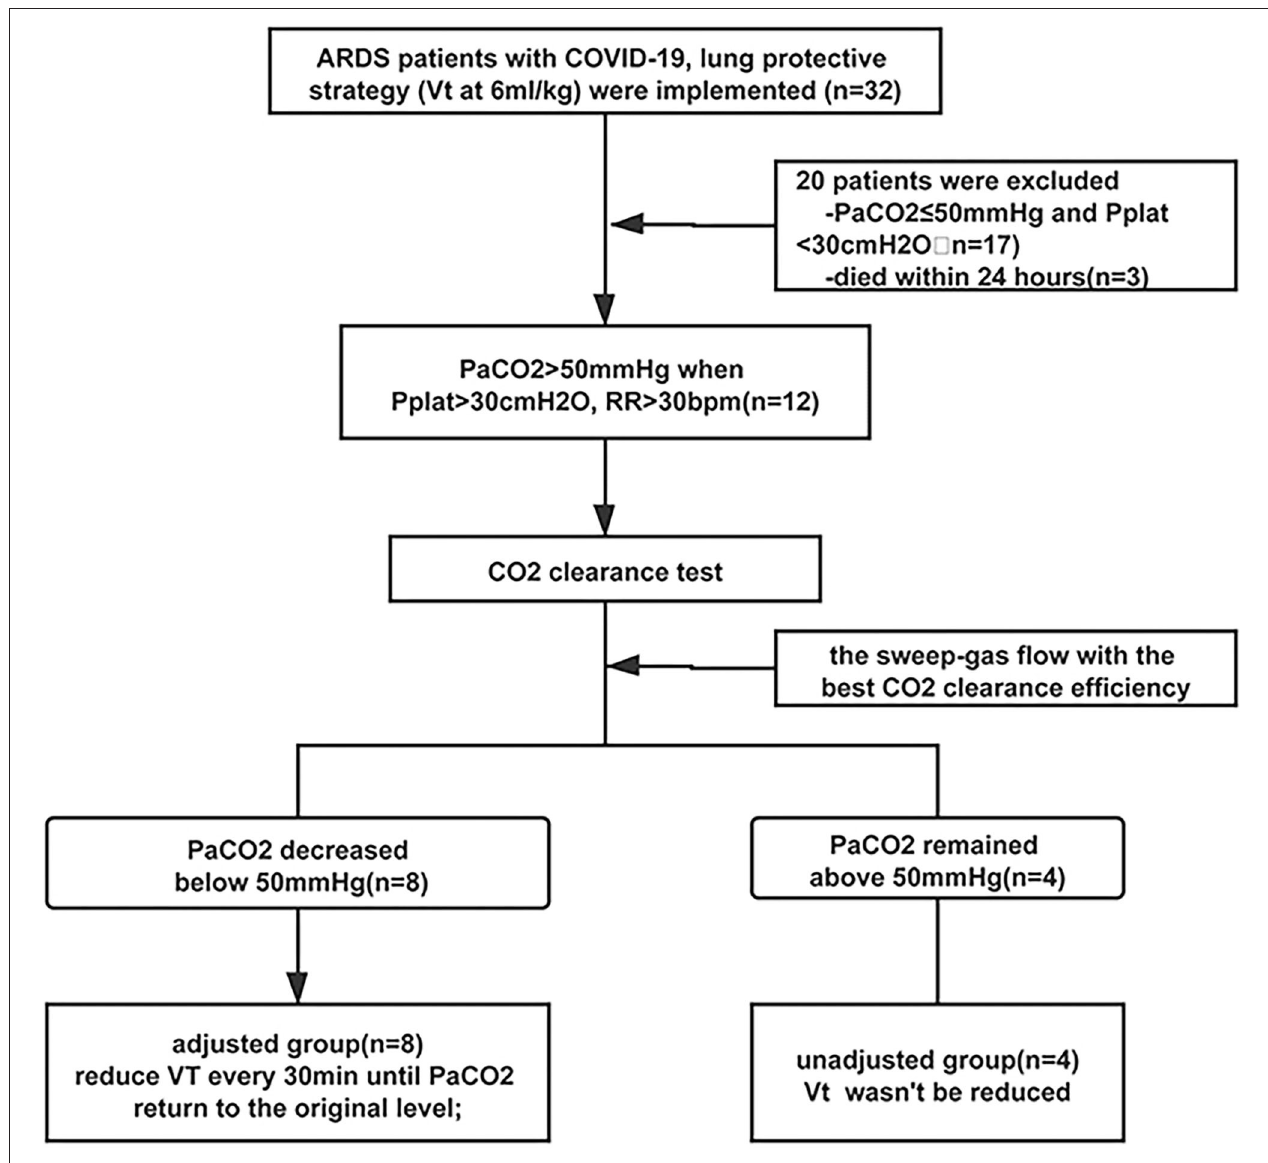
FIGURE 2 | Flowchart of the